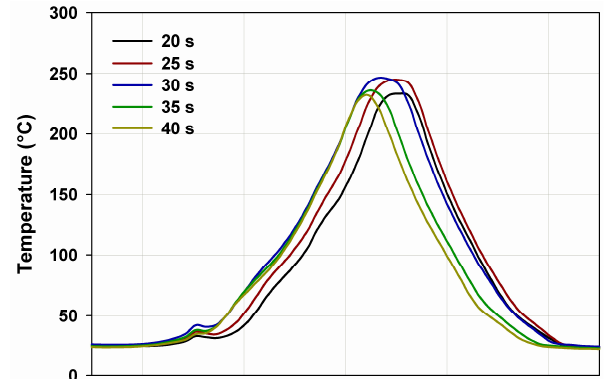
Figure 12. Thermograms of sample 6 (BPA.DM-NVP-5) recorded: 20 ( a ), 25 ( b ), 30 ( c ), 35 ( d ) and 40 ( e ) seconds after the ignition source application.